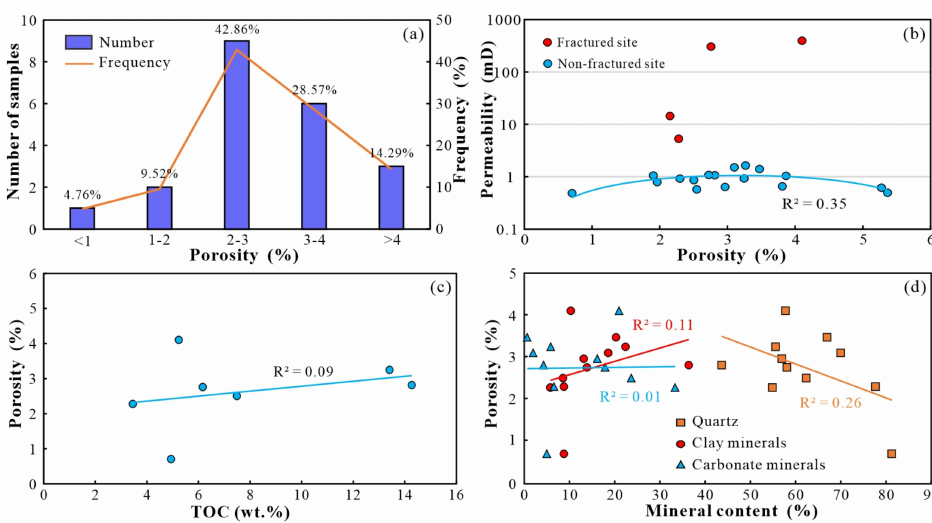
Figure 7. ( a ) Porosity distribution, ( b ) Permeability vs. porosity, ( c ) Porosity vs. TOC, ( d ) Porosity vs. mineral contents in the Dalong Formation